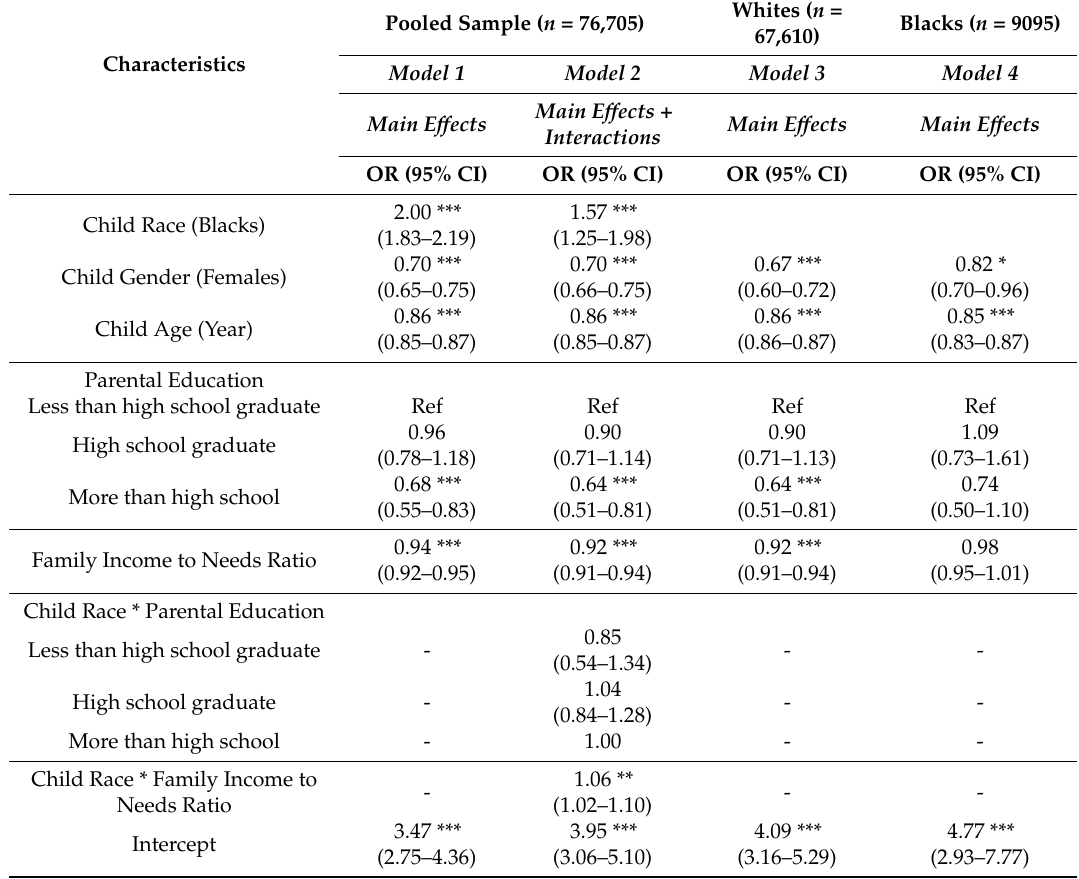
Table 3. Summary of linear regression models in the pooled sample and by